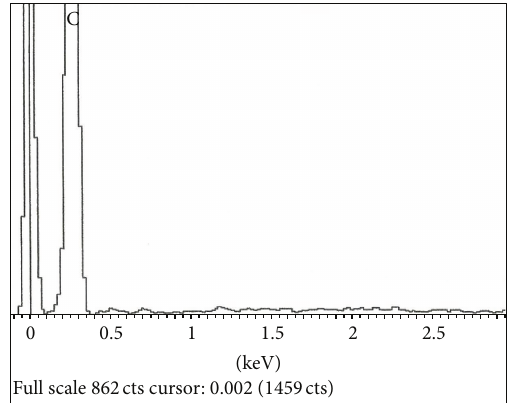
Figure 3: The EDX result of carbon nanospheres